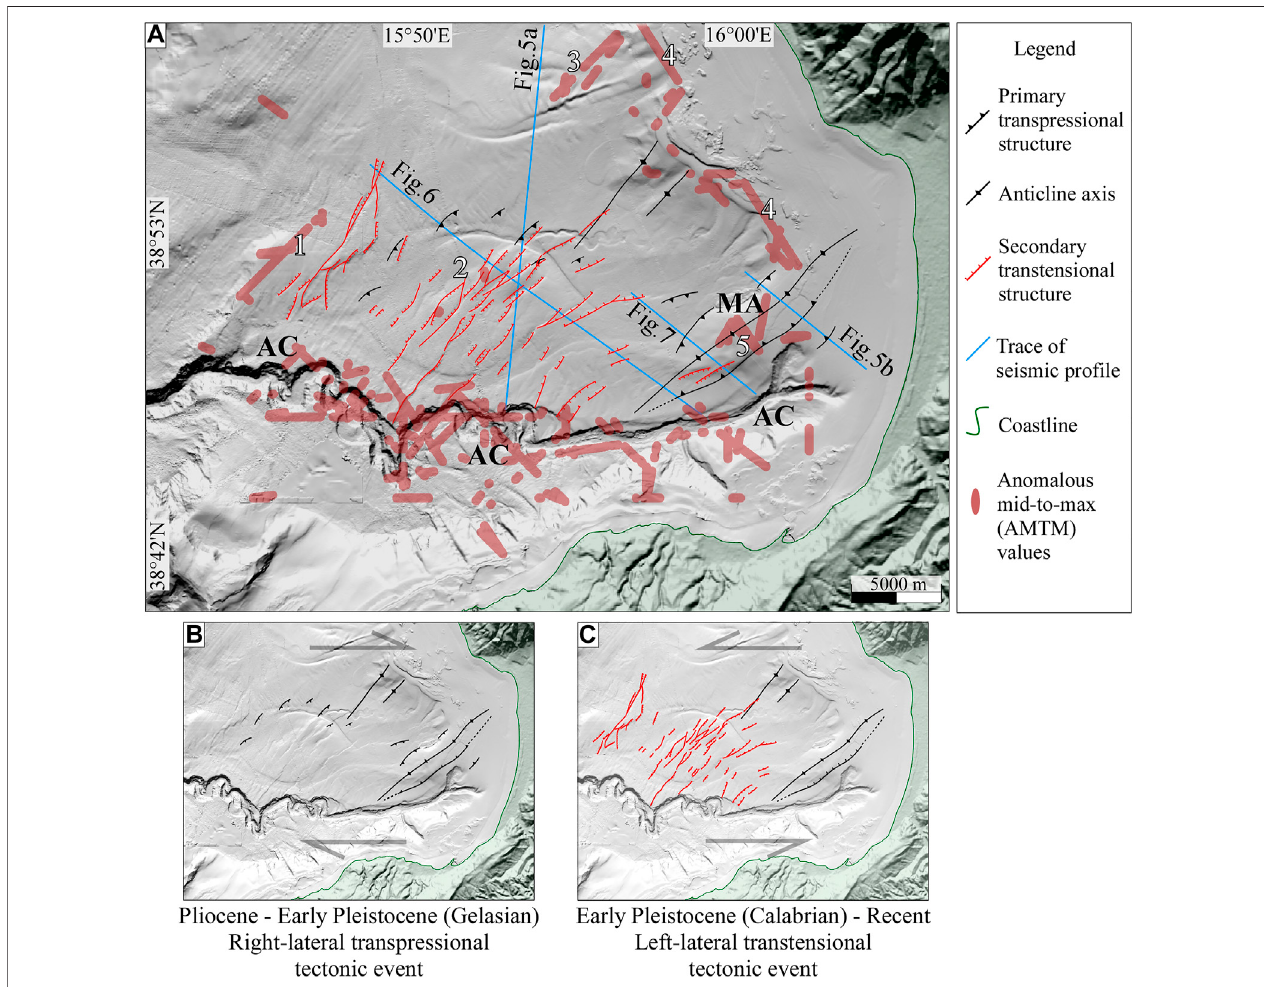
FIGURE8|(A) StructuralmapoftheSant ’ EufemiaGulf.ReddotsaretheAMTMvalueslocalisedattheintersectionpointsoftheirrelatedswathpro fi les.MA,Maida Ridge; AC, Angitola Canyon; 1, 2, 3, 4, and 5, sectors with alignments of AMTM values. (B and C) Schematic structural maps showing the active structures during the Pliocene — Early Pleistocene (Gelasian) and Early Pleistocene (Calabrian) — Recent tectonic events that affected the Sant ’ Eufemia Gulf. The activity of the structures is inferred from the analysis of seismic pro fi les and swath pro fi les (AMTM values).